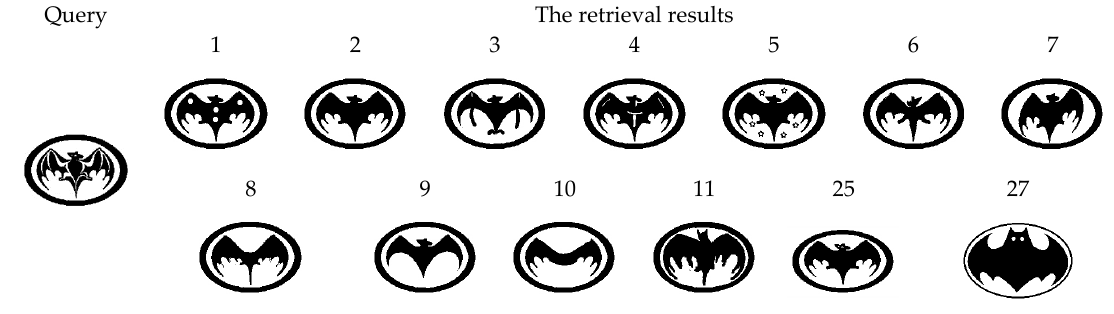
Figure 15. Retrieval results for the query image in the class 2.